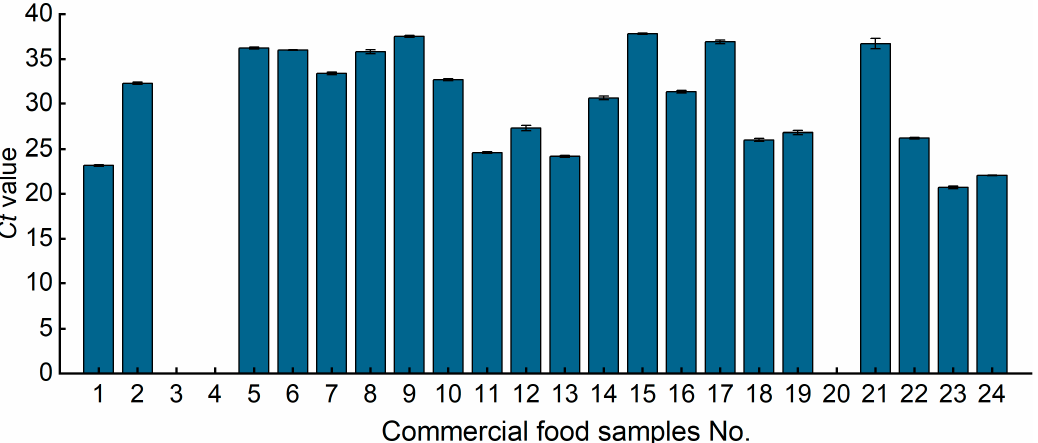
Figure 5. Detection of commercial food samples containing quinoa, coix seed, wild rice and chickpea. The number of samples were consistent with the “Food samples’ name” in Table S5. A total of 24 commercial food samples with labels indicating presence of coix seed (No. 1–10), chickpea (No. 11–17), quinoa (No. 18–22) and wild rice (No. 23 and 24), including baking food, canned food, and instant food were analyzed by qPCR, and corresponding target components were detected. A total of 21 samples were consistent with the commodity labels; two coix seed samples (No. 3 and 4) were identified that did not contain coix seed component and one quinoa sample (No. 20) did not detect a quinoa component.